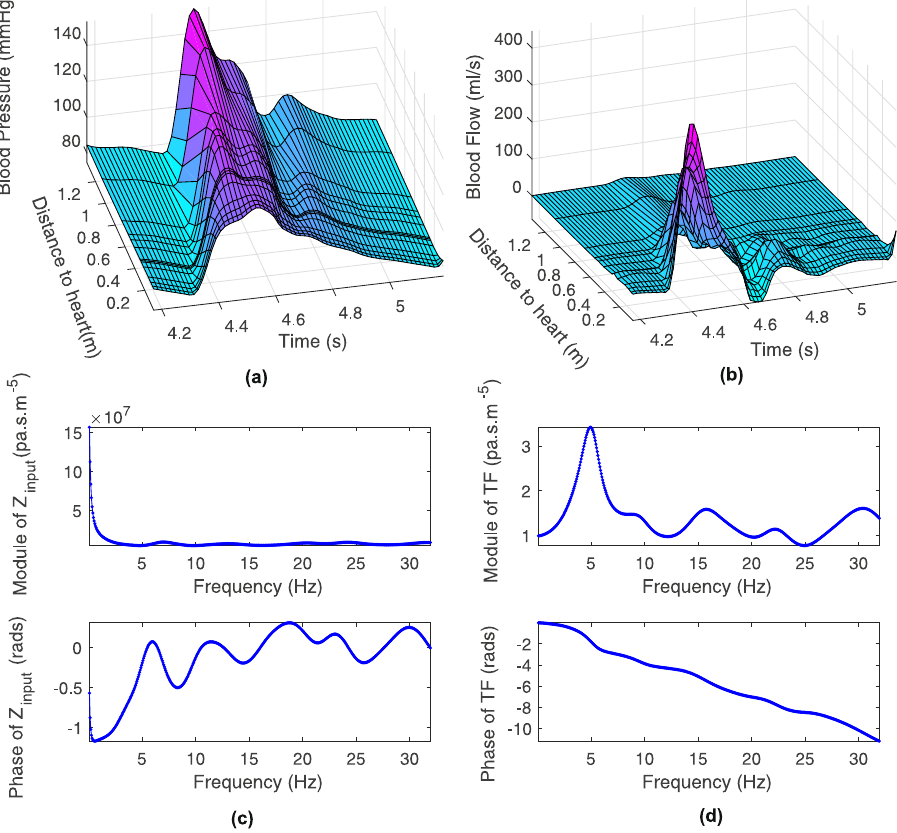
Figure 5. Simulation results: ( a ) blood pressure distribution and ( b ) blood flow distribution from aorta to tibial artery, ( c ) input impedance of ascending aorta and ( d ) transfer function between ascending aorta and brachial